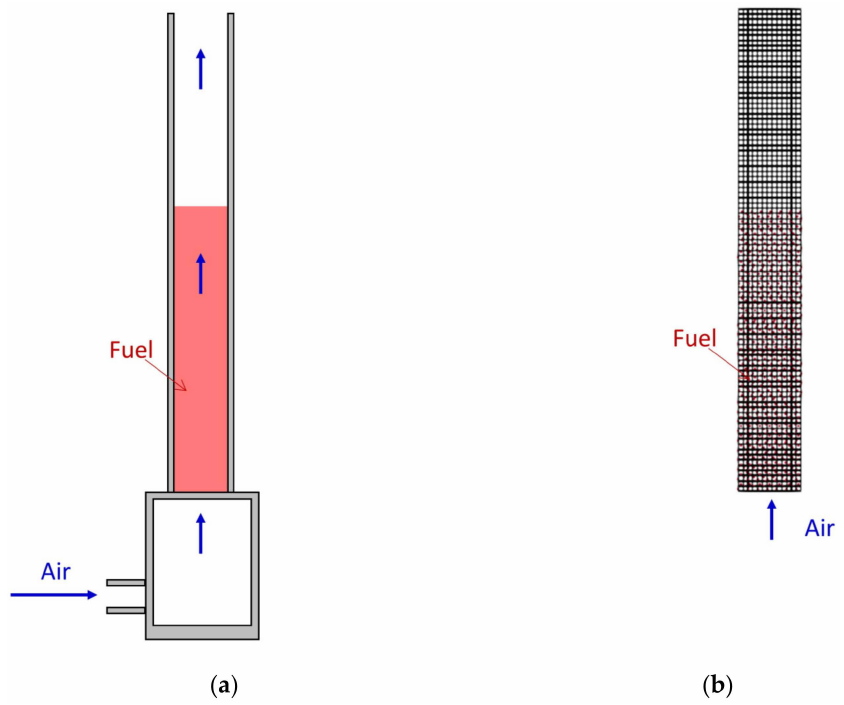
Figure 1. Cylindrical combustor. ( a ) Scheme of the experimental system; ( b ) computational domain.